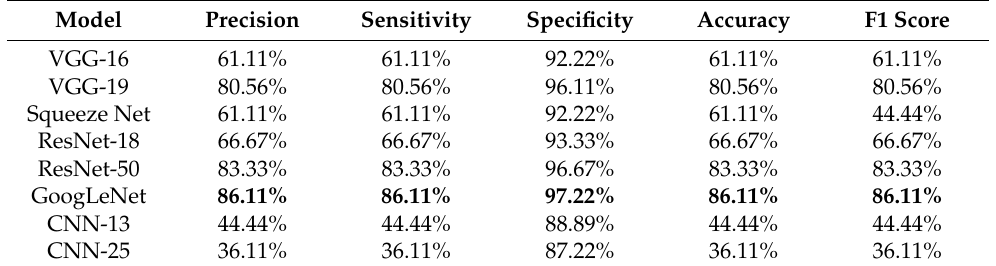
Table 2. Performance metrics of retrained models and typical CNN models with data augmentation.